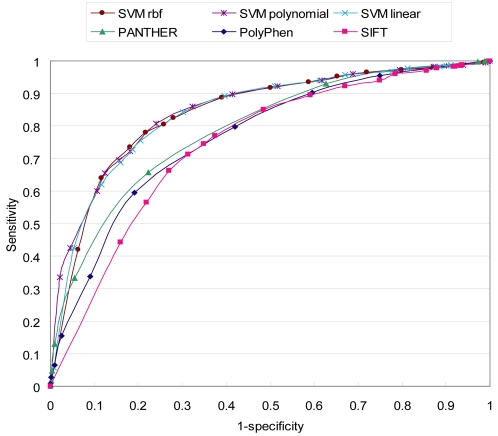
Receiver Operating Characteristic (ROC) curves of the combination and individual predictors.The ROC curves of SVM combination predictors tend toward the upper left corner of the plot more than the three individual prediction programs. This suggests that SVM combinations outperform the individual prediction programs. SVMpolynomial showed a specificity of 75.9% and a sensitivity of 80.7% when the threshold of SVM combination score was 0.8 (see Table 5).